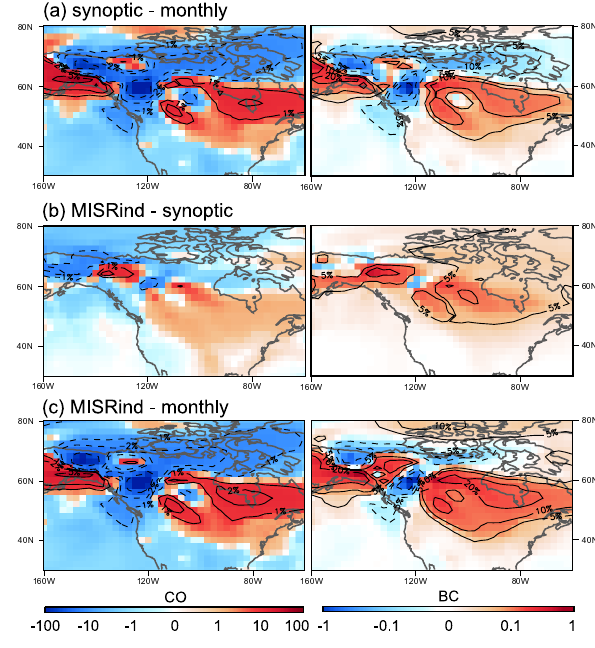
Fig. 7. Impacts of biomass burning emission temporal and injection height distribution on simulated 3-month (June–August 2004) aver- age CO (left columns) and BC (right columns) column burdens in North America. The absolute differences (kg/km 2 ) are shown in red and blue grid cells. The relative changes (in percentage) are shown in line